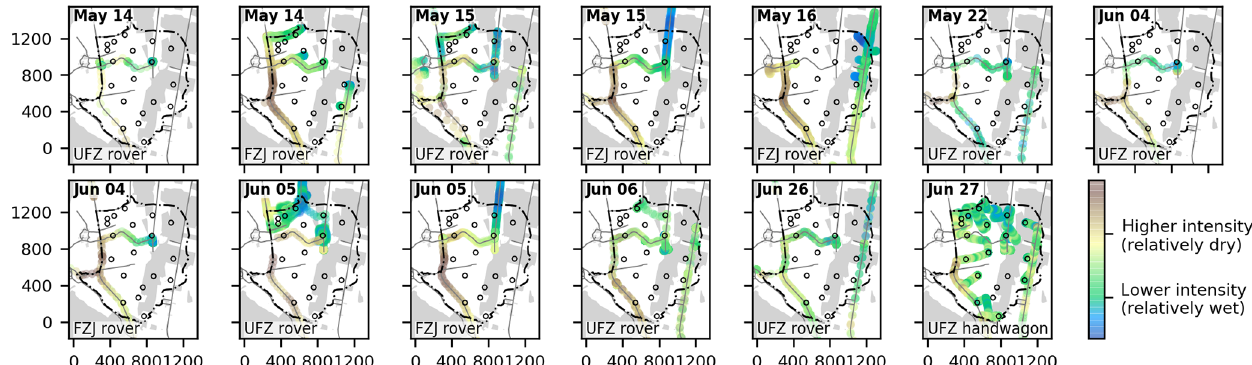
Figure 6. Roving tracks and relative neutron intensity. Each panel represents a roving campaign day and a rover type (UFZ rover, FZJ rover, hand wagon). The color code qualitatively indicates the variability of observed corrected neutron intensity within a single roving campaign, where a higher neutron intensity corresponds to drier conditions. Forested and built-up areas as well as roads are shown in gray, and the watershed is represented by the broken black line; stationary CRNS sensor locations are printed with black circles. Basemap data are from OSM (OpenStreetMap contributors, 2020); see Sect.